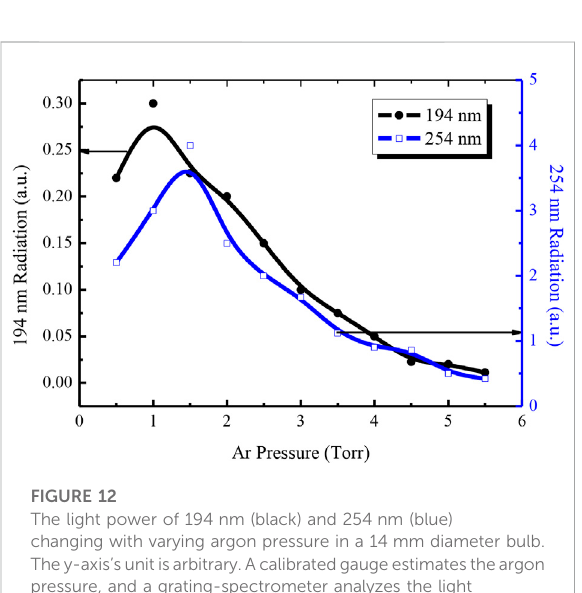
FIGURE 12 The light power of 194 nm (black) and 254 nm (blue) changing with varying argon pressure in a 14 mm diameter bulb. They-axis ’ sunitisarbitrary.Acalibratedgaugeestimatestheargon pressure, and a grating-spectrometer analyzes the light intensity.